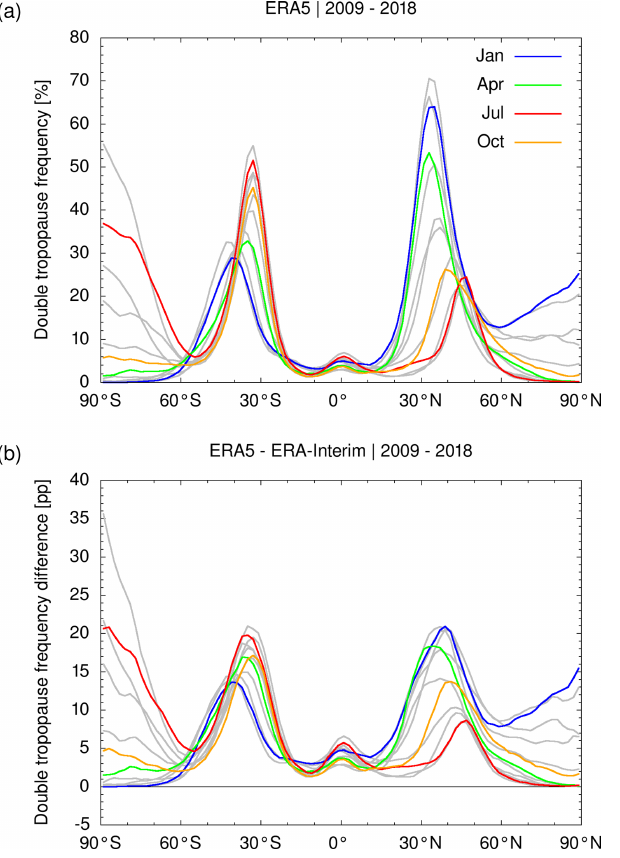
Figure 8. Monthly mean zonal mean double-tropopause occurrence frequencies in the ERA5 reanalysis (a) and corresponding differ- ences between ERA5 and ERA-Interim (b) in percentage points (pp). The statistics shown here were calculated for 2 ◦ latitude bins from 120 million global random samples of the ERA5 reanalysis data covering the time period from January 2009 to December